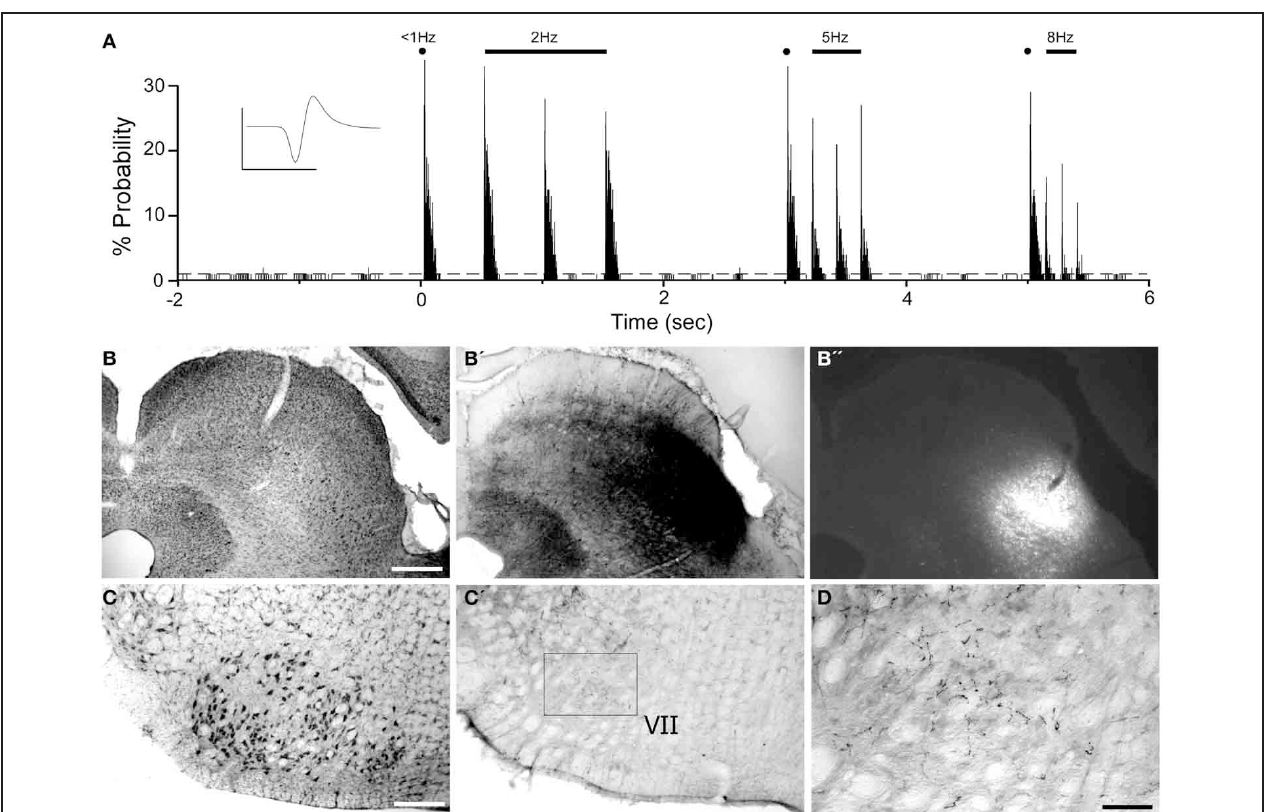
FIGURE 11 | Whisker-responsive region in the superior colliculus (SC) projects to the contralateral facial nucleus. (A) PSTH illustrating the whisker-induced responses of a SC neuron recorded by a pipette containing FG and BDA. (B) Nissl-stained coronal section showing the laminar location of BDA (B (cid:2) ) and FG (B (cid:2)(cid:2) ) injections at the